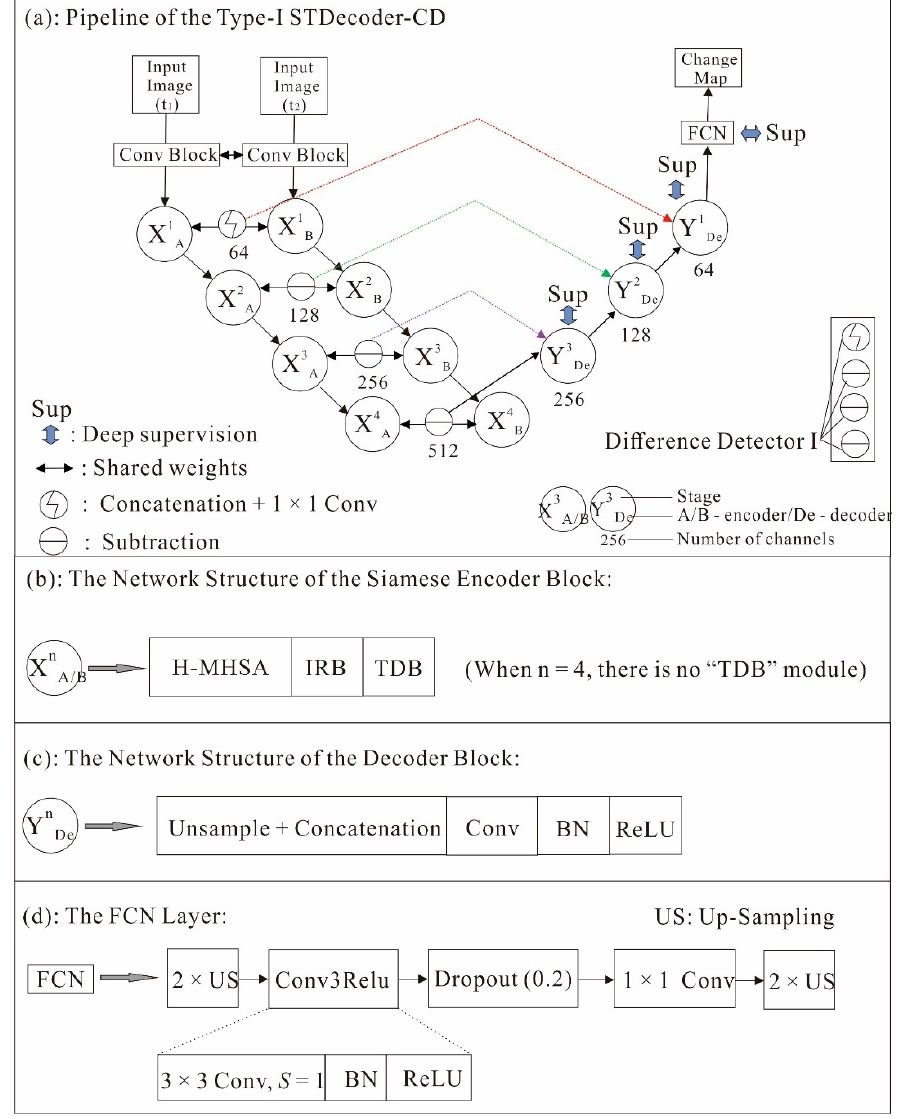
Figure 2. Flowchart of the Type I STDecoder-CD architecture. The legends in this figure are consistent with those in Figure 1 if not